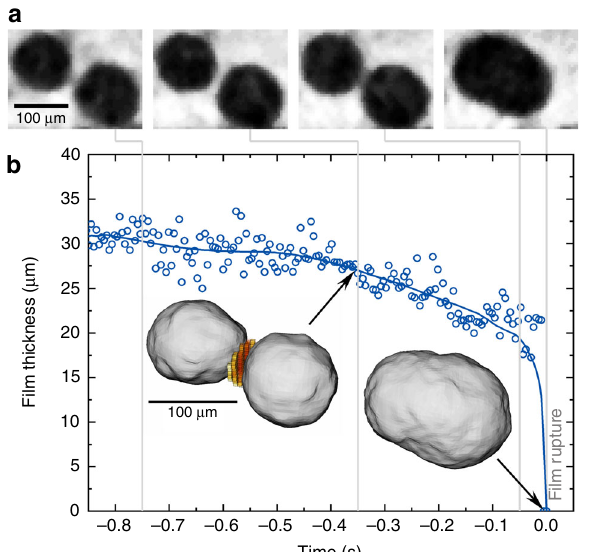
Fig. 3 Phenomena preceding fi lm rupture as measured by X-ray tomoscopy. Liquid foam (same alloy as in Fig. 2) is observed by tomoscopy with 208 tps acquisition rate. a Four tomographic slices at different times (grey lines) showing two approaching bubbles. b Film thickness over time shown for a period of ~ 1 s before the fi lm between the two bubbles ruptures at t = 0 s. Insets: rendering of the two bubbles and the corresponding fi lm separating them (given in red and yellow) and the resulting bubble after coalescence